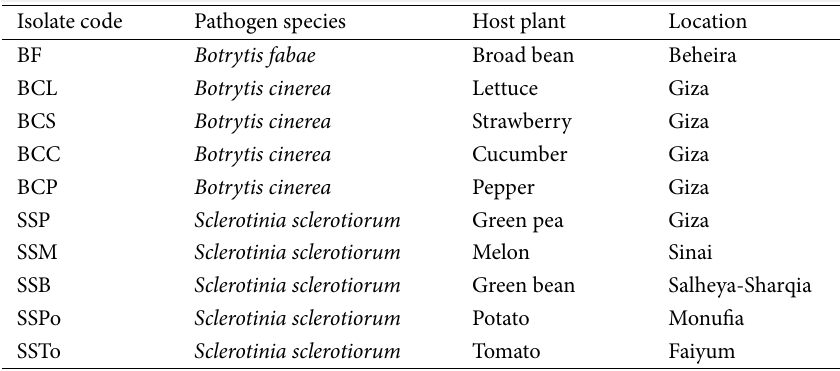
Table 1 Collection of Botrytis and Sclerotinia